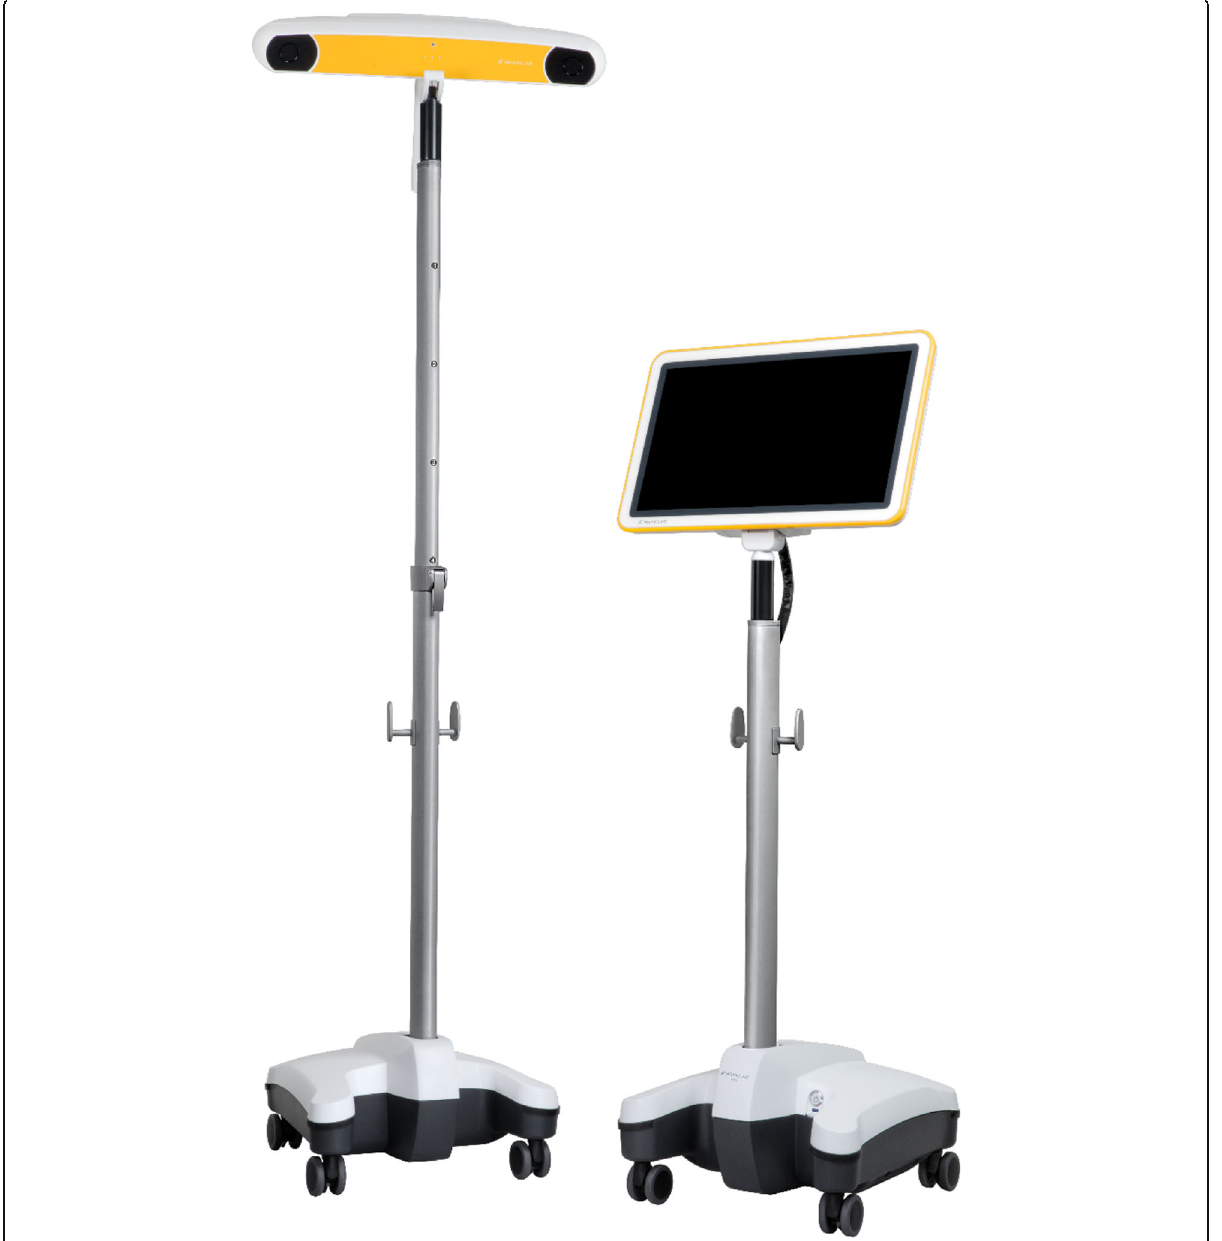
Fig. 1 BrainLab navigation unit illustrating motion capture camera and computer screen